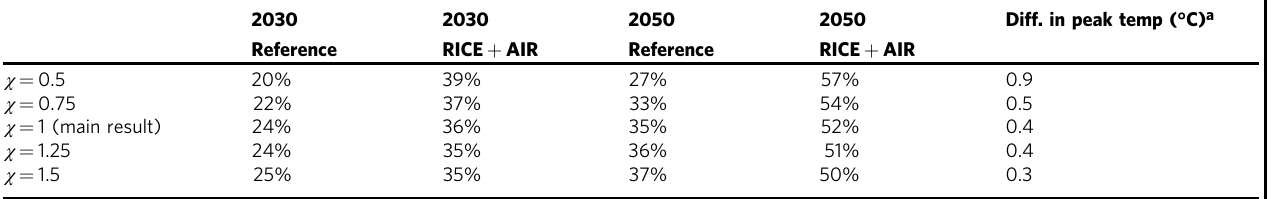
Table 1 Impact of independent air quality